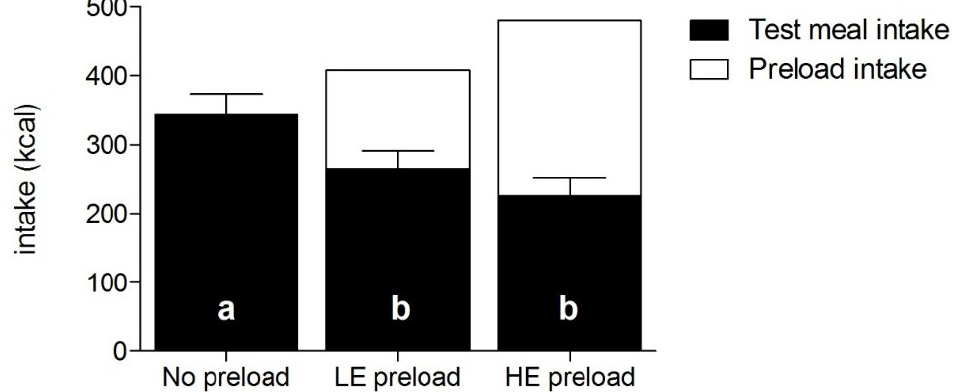
Figure 1. Mean intake (kcal ± SEM) of the fixed yogurt-based preload and of the ad libitum test meal consisting of sandwiches. a, b Ad libitum intake was greater when no preload was served (a) than following both the low-energy (LE) and the high-energy (HE) preload